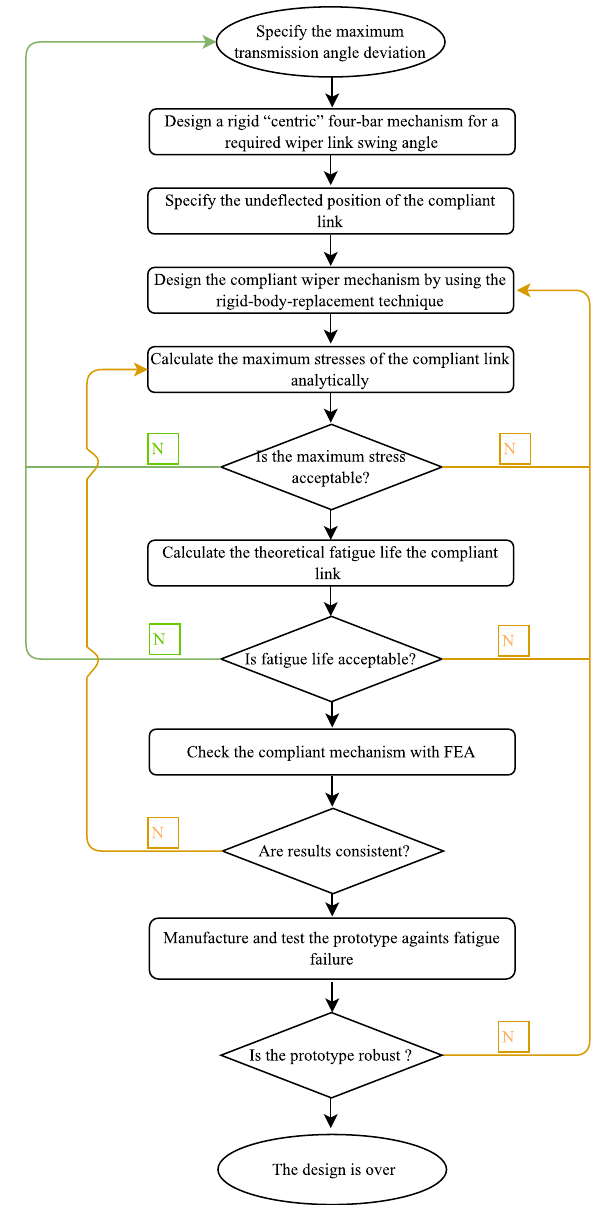
Figure 2. Flowchart diagram of the design